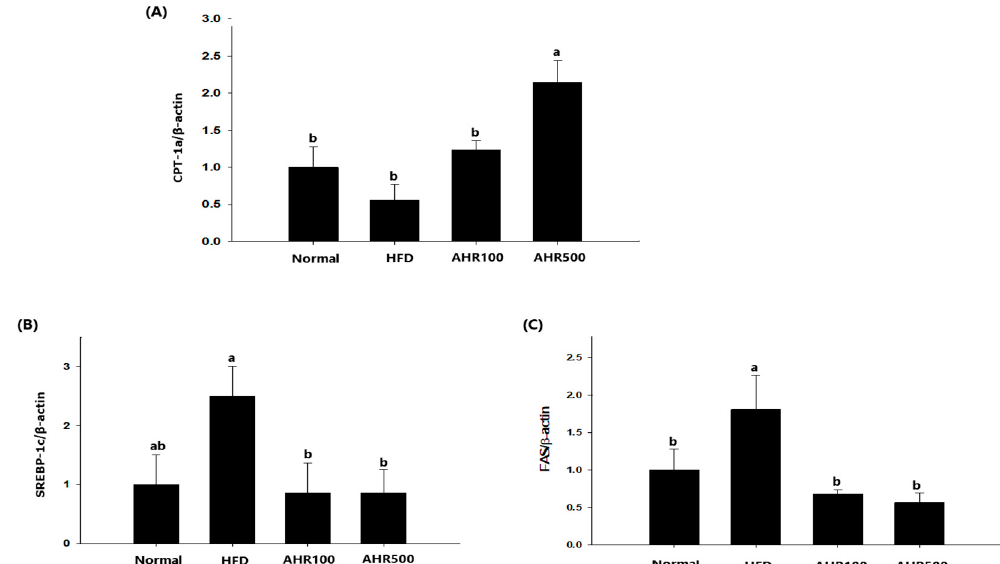
Figure 6. E ff ects of AHR on hepatic mRNA levels of CPT-1a ( A ), SREBP-1c ( B ), and FAS ( C ) in